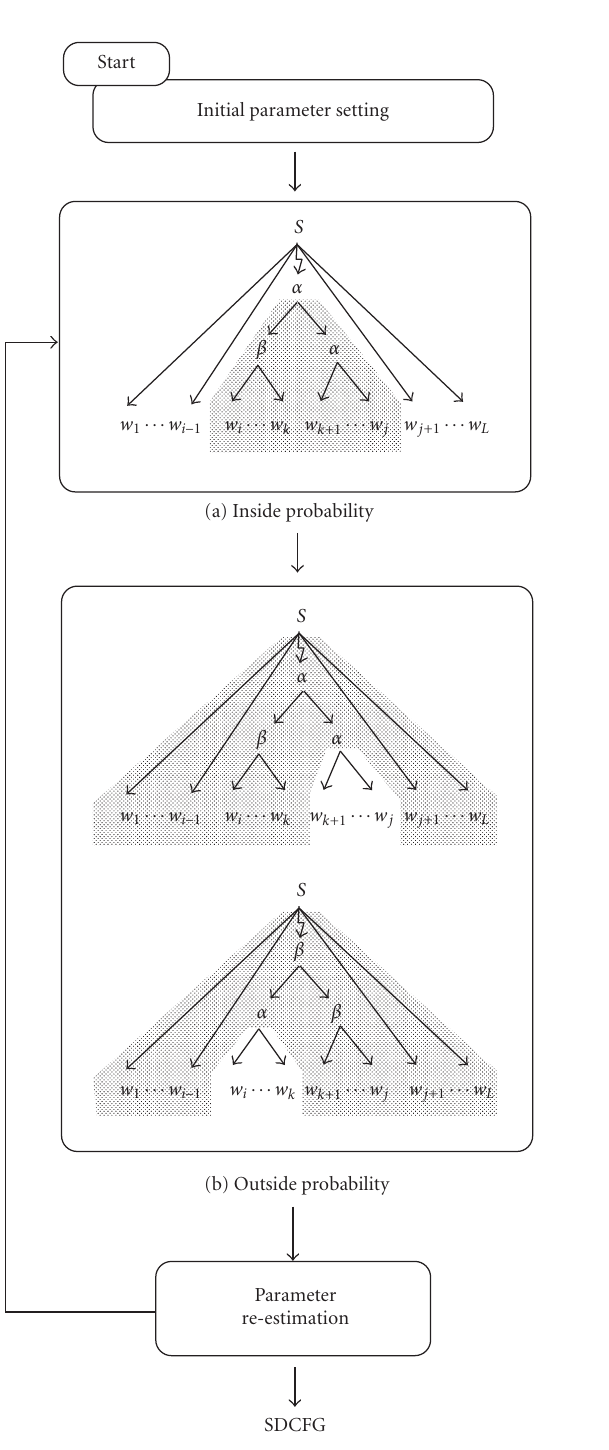
Figure 11: Estimation algorithm for SDCFG.